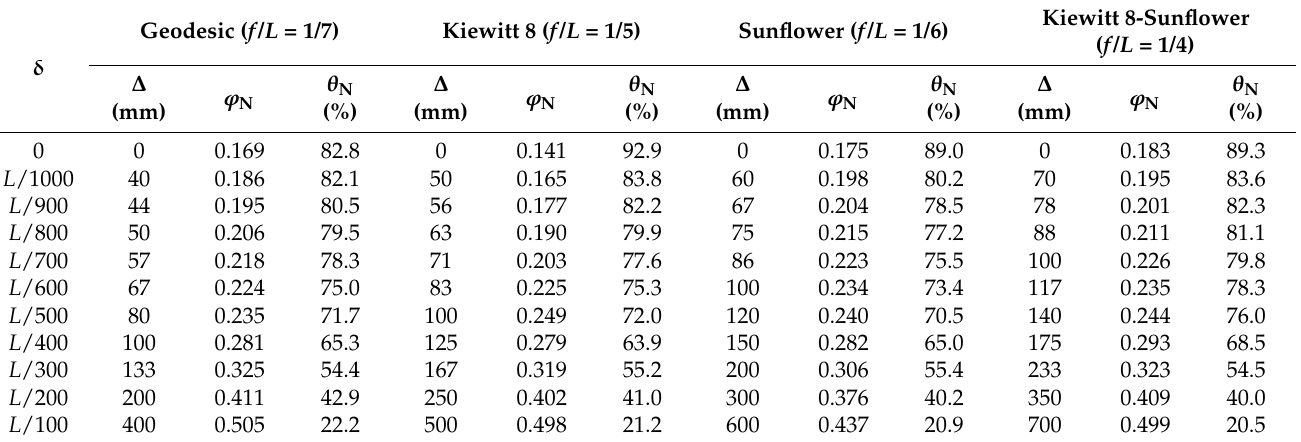
Table 3. The SFS under different